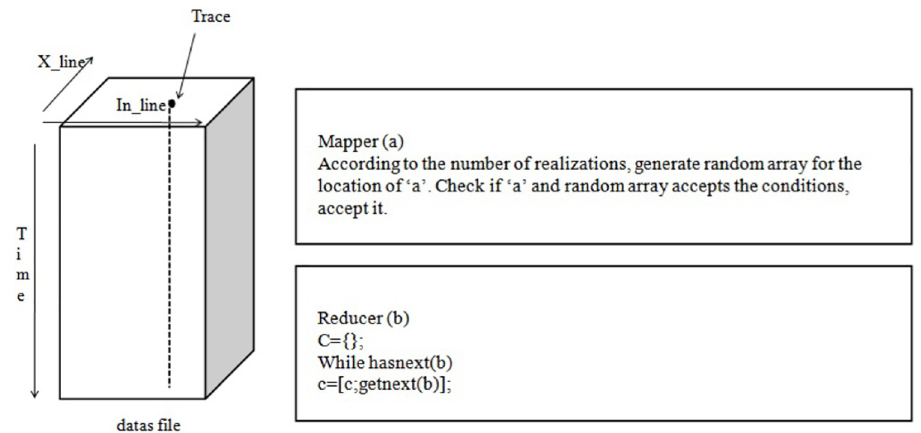
Fig 7. Mapper and Reducer function for stochstic inversion